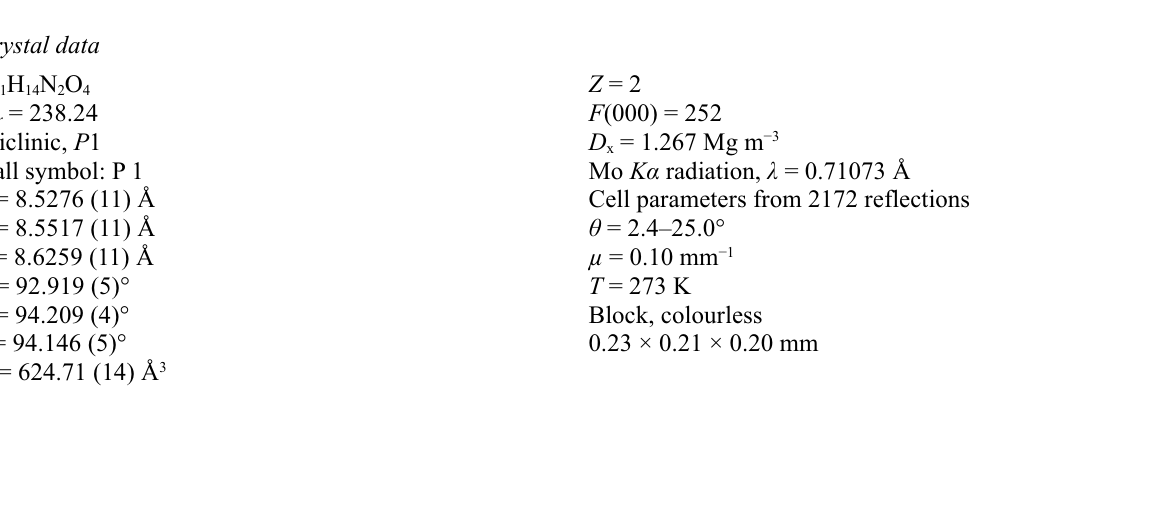
Crystal packing of the title compound, viewed approximately down the a axis. Dashed lines indicate hydrogen bonds. H atoms not intervening in H-bonding were eliminated for